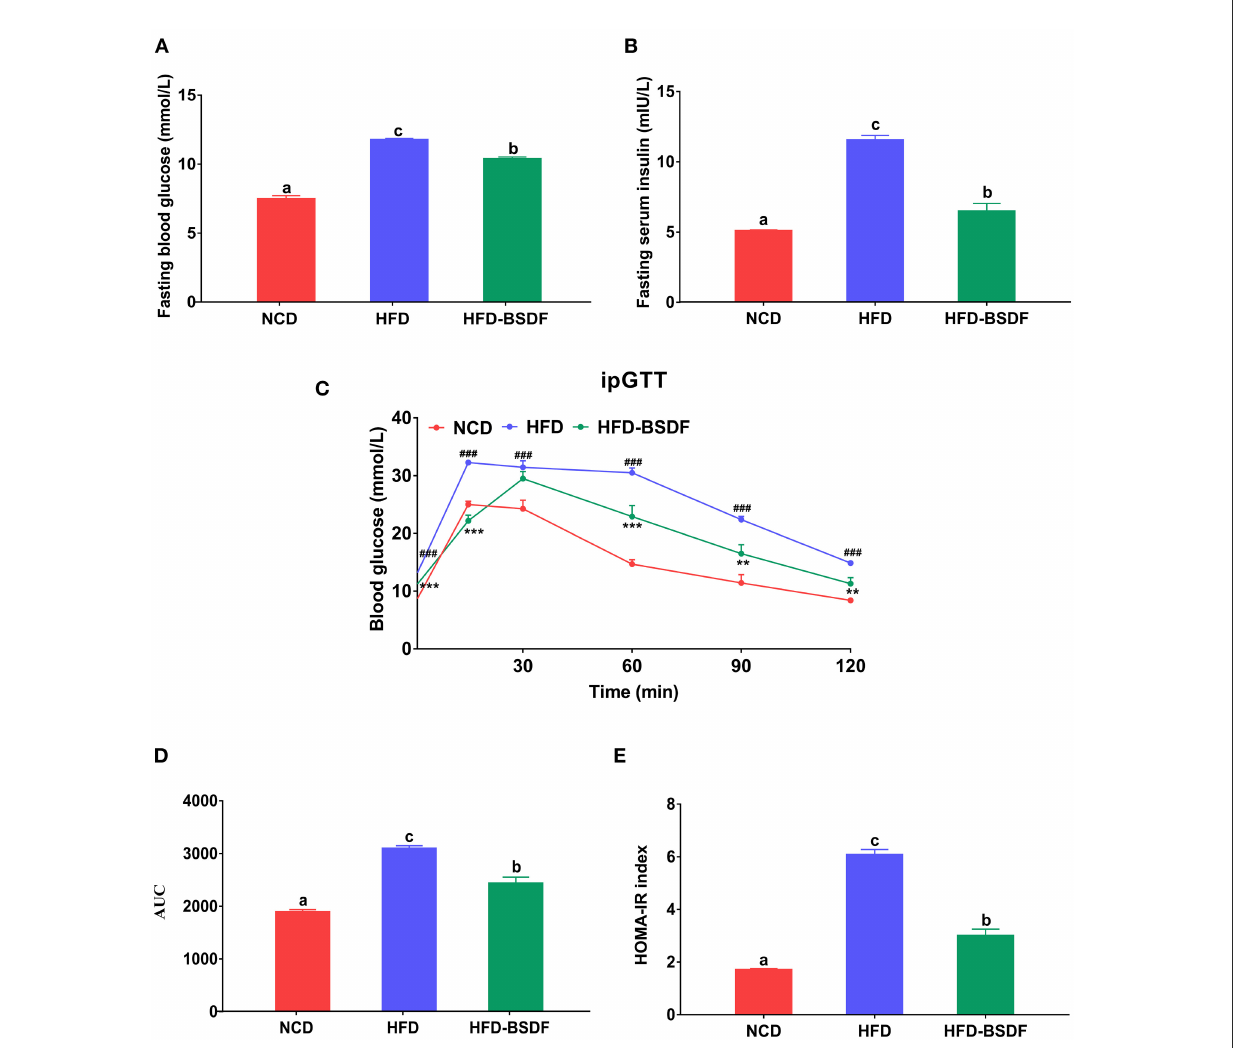
FIGURE2 BSDF improved insulin resistance and glucose tolerance in HFD-fed mice. (A) Serum glucose, (B) serum insulin, (C) time courses of blood glucose levels in the intraperitoneal glucose tolerance test (iPGTT) (D) Area under the curve (AUC) of the blood glucose during ipGTT. (E) homeostatic model assessment for insulin resistance (HOMA-IR) index, and Data presented as mean ± SEM, n = 8 . ### p < 0.001, HFD vs. NCD; ** p < 0.01, *** p < 0.001, HFD-BSDF vs. HFD. a, b, c means in the same bar without a common letter differ at p < 0.05. NCD, normal control diet; HFD, high-fat